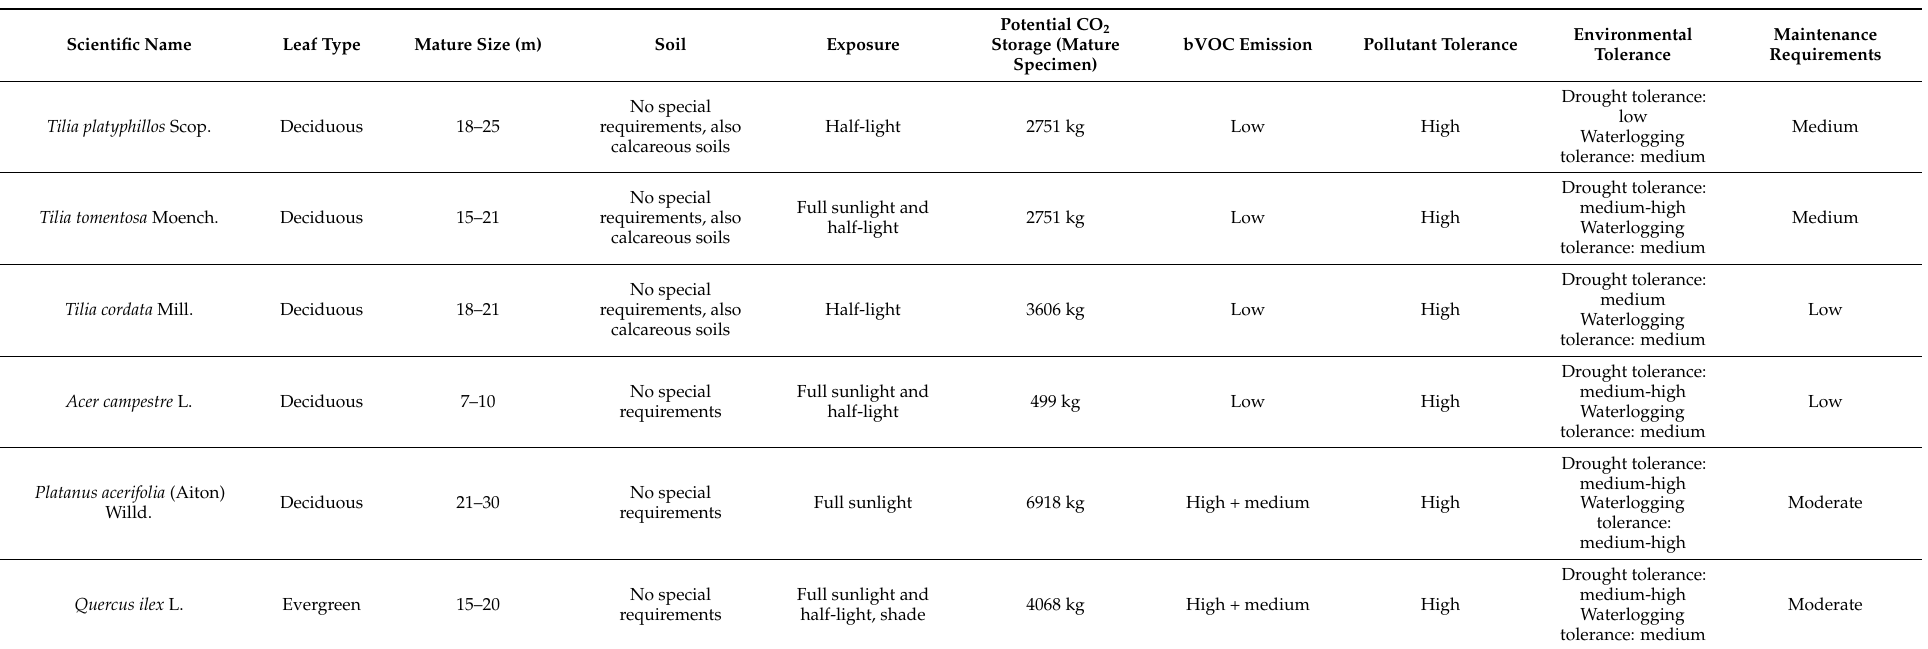
Table 2. Recommended species and selection criteria